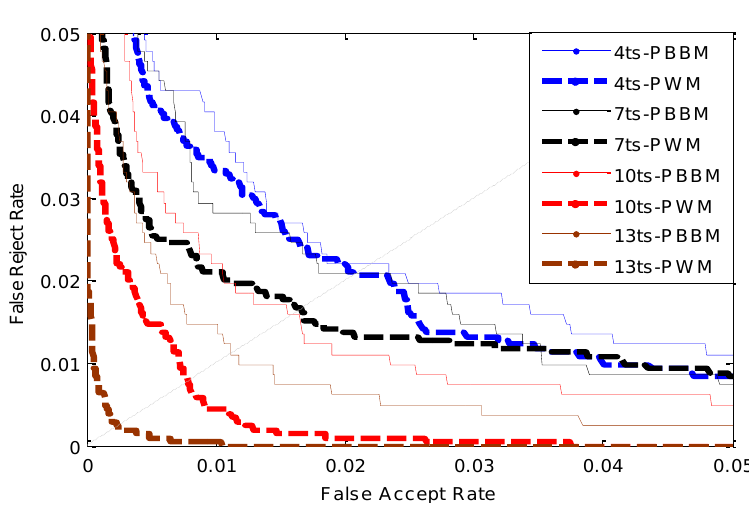
Figure 15. ROC curves by different